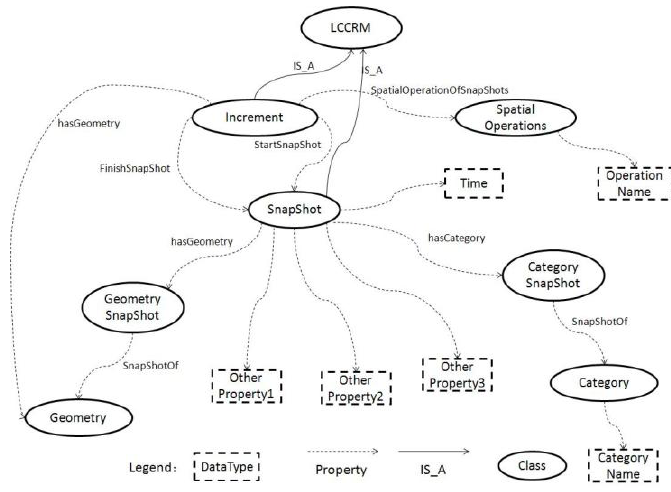
Fig 3. Representation Model of Land Cover